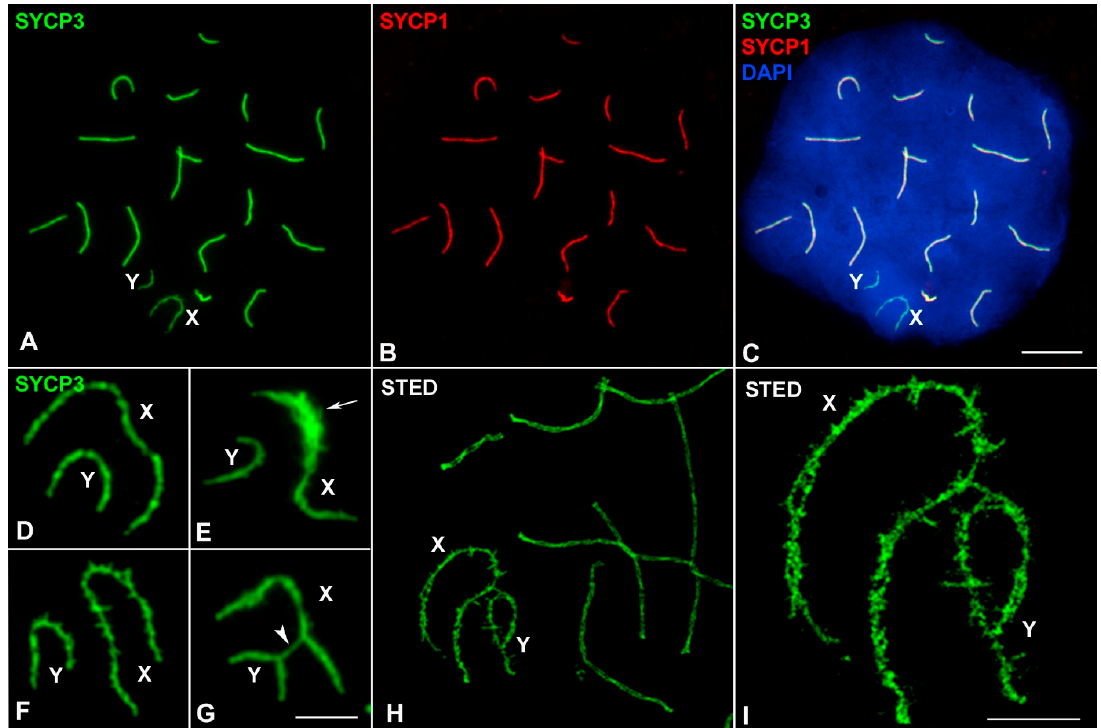
Figure 3. Structural organization of sex chromosomes in prophase-I. ( A – C ) Mid pachytene spermatocyte labelled with SYCP3 (green), SYCP1 (red) and DAPI (blue). SYCP1 is absent in the sex chromosomes. A well-defined sex body is observed with DAPI staining. ( D – G ) Details of the AEs of the sex chromosomes. ( D ) AEs without obvious modifications. ( E ) The AE of the X chromosome is thickened in an interstitial region (arrow). ( F ) Lateral excrescences are observed in both sex chromosomes. ( G ) Bridges of SYCP3 are occasionally observed between the AEs of sex chromosomes (arrowhead). ( H ) A pachytene spermatocyte observed with super-resolution STED confocal microscopy. The two LEs of autosomes are distinguishable. ( I ) Enlarged image showing sex chromosomes. The AEs of both chromosomes are irregular and show profuse excrescences and splitting into two filaments along their trajectory. Scale bars: 10 µm in ( A – C ); 5 µm in ( D – I ).